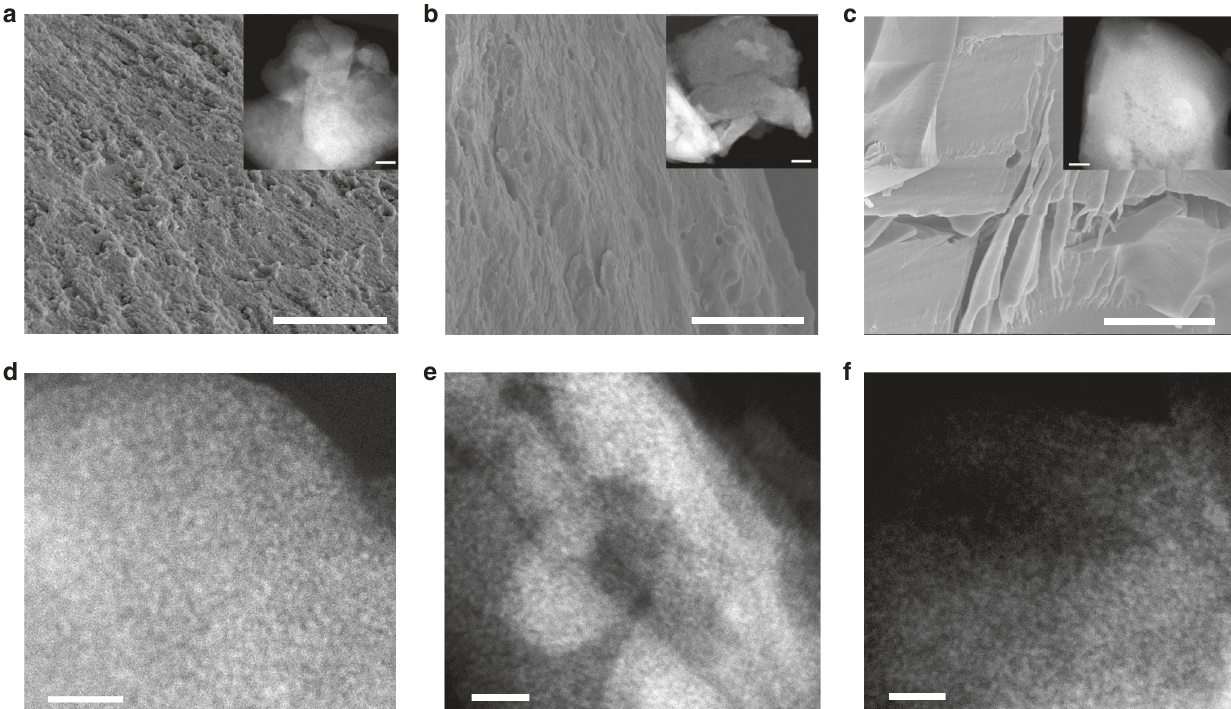
Fig. 2 Electron microscopy of hydrogels. a – c SEM and STEM HAADF images of hydrogels. The scale bar of inset HAADF images is 50 nm. d – f High- magni fi cation HAADF images of hydrogels. The images show Hydrogel-544 ( a , d ), Hydrogel-590 ( b , e ), and Hydrogel-618 ( c , f ). Scale bar in a – c : 5 μ m, Scale bar in d – f : 20